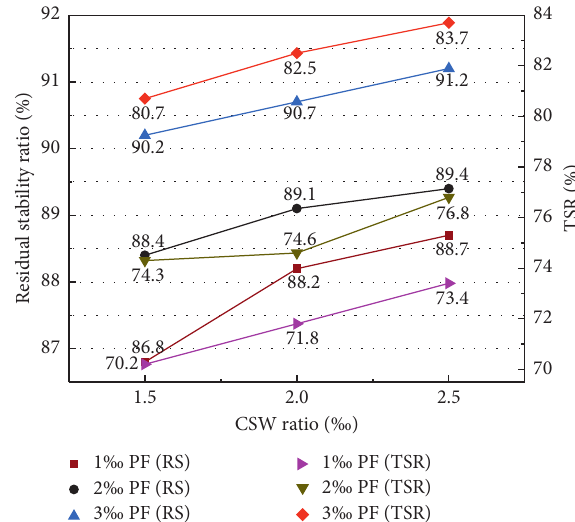
Figure 2: Water stability test